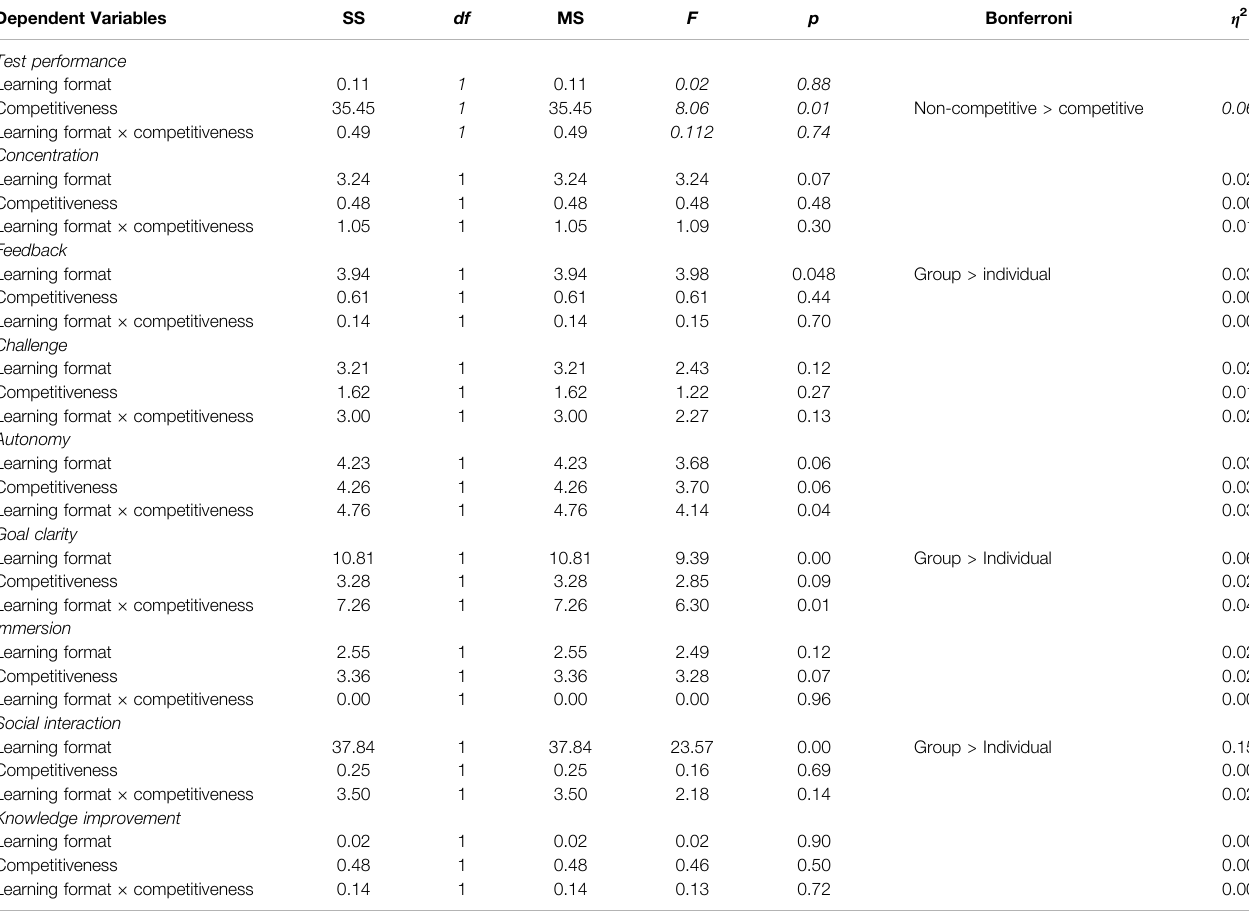
TABLE 4 | Results of two-way ANOVA on learning outcomes and eGame fl ow.